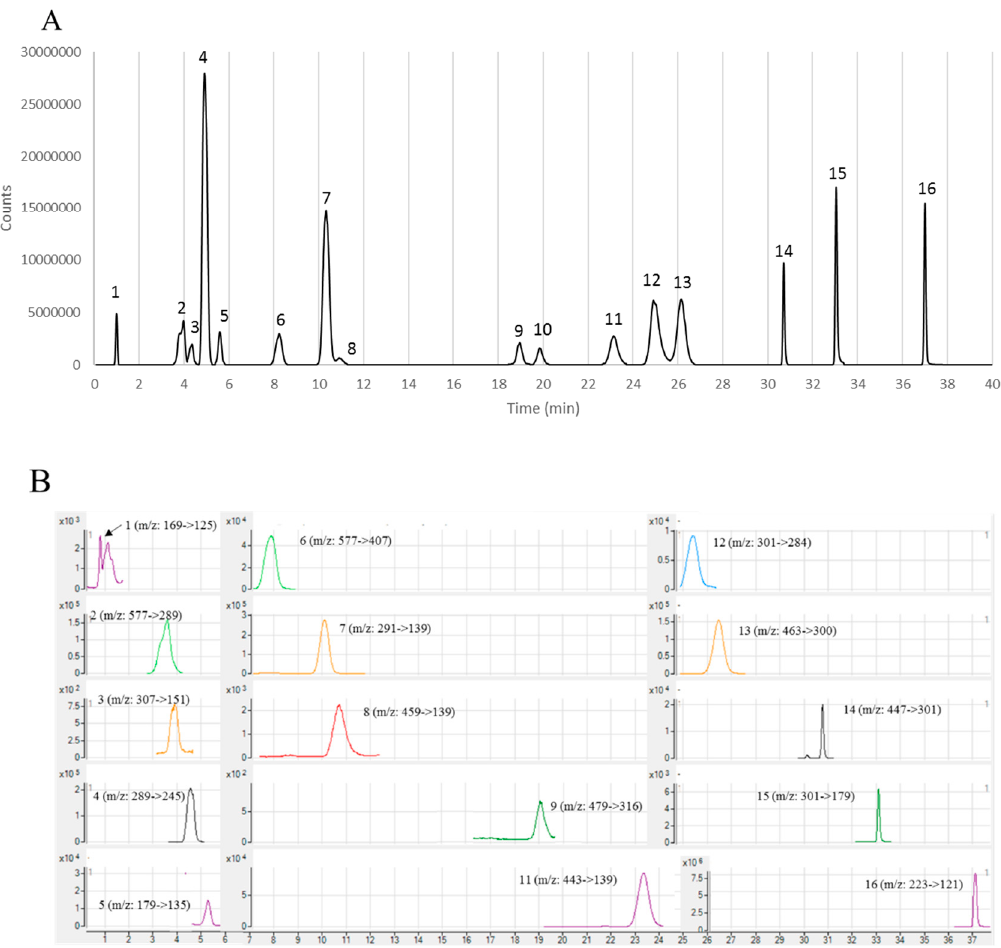
Figure 2. ( A ) Total ion chromatogram of the mixed standards. ( B ) Representative LC-MS chromatogram of the extracted MRM transitions of the identified phenolic compounds in feijoa peel extracts from the Unique cultivar. 1, gallic acid; 2, procyanidin B1; 3, epigallocatechin; 4, catechin; 5, ca ff eic acid; 6, procyanidin B2; 7, epicatechin; 8, epigallocatechin gallate; 9, myricetin-3- O -galactoside; 10, myricetin-3- O -glucoside; 11, epicatechin gallate; 12, ellagic acid; 13, quercetin-3-galactoside; 14, quercetin-3-rhamnoside; 15, quercetin; 16,